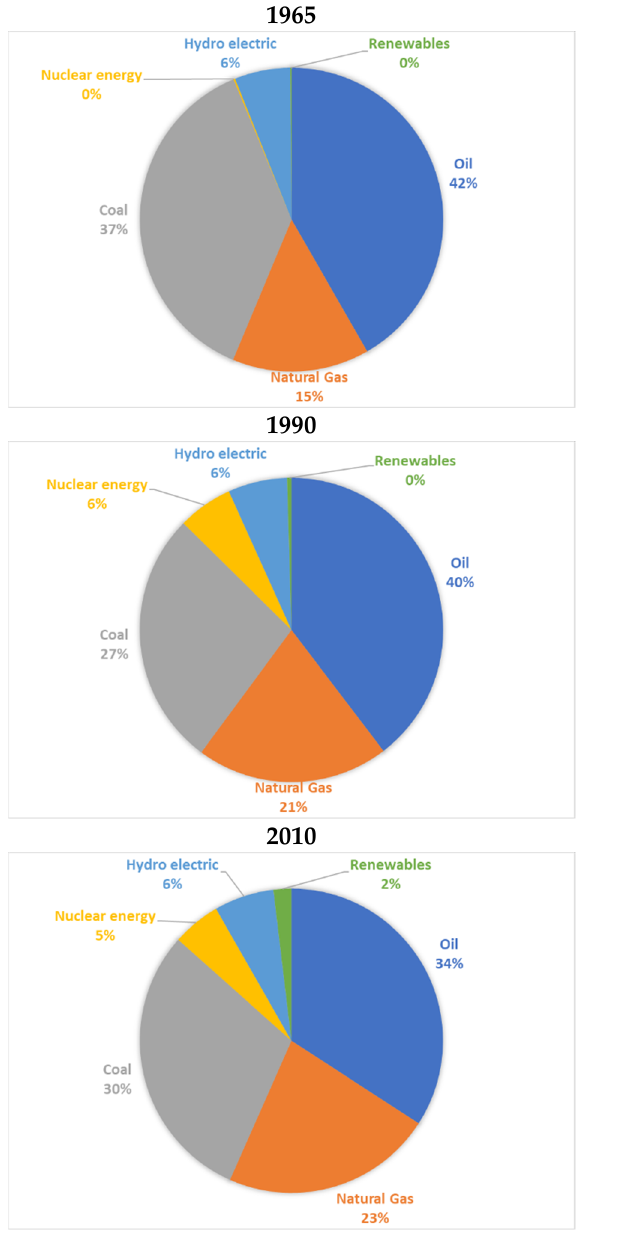
Figure 3. The dynamics of changes in the structure of the world fuel and energy balance, calculated by authors using [5].